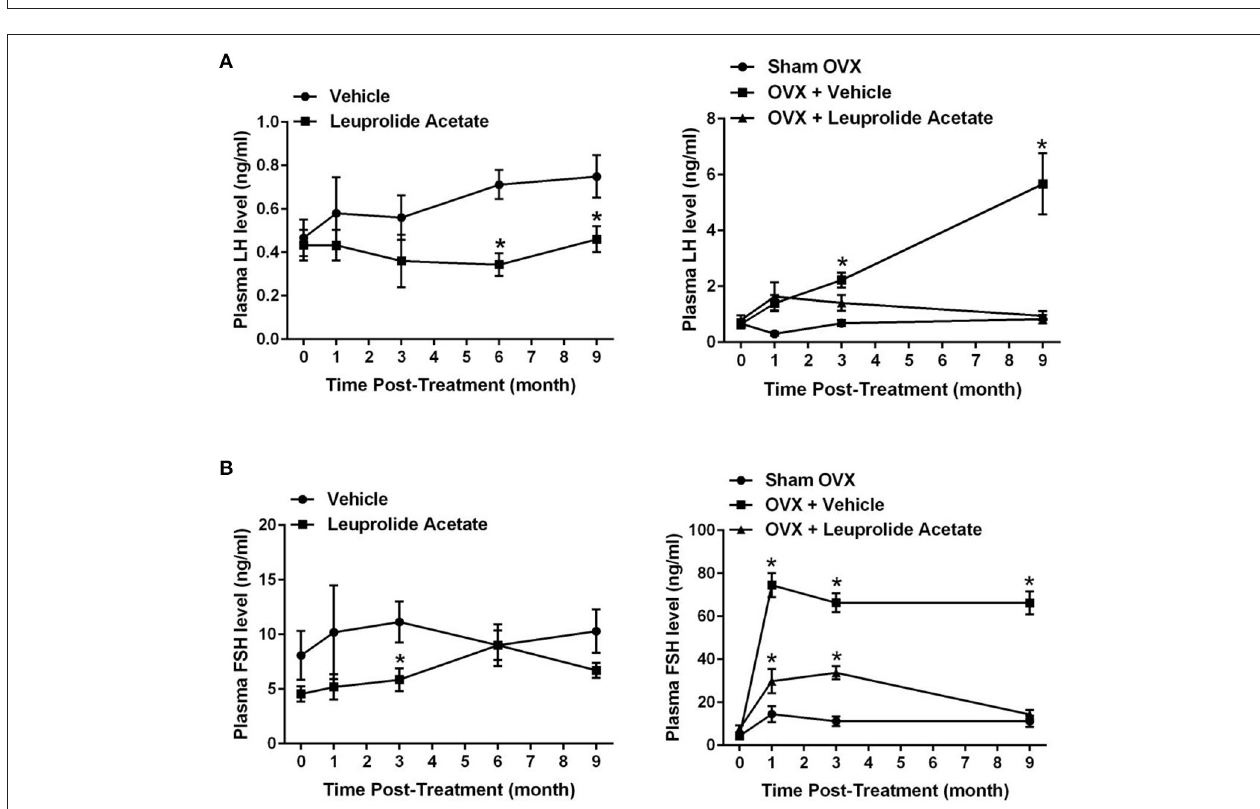
FIGURE 2 | Changes in plasma LH and FSH with aging in ovariectomized and leuprolide acetate treated mice. Female C57B6JL mice at the age of 7.5 months were treated either with vehicle (saline) or leuprolide acetate (1.5 mg/kg) monthly, blood was taken at 0, 1, 3, 6, and 9 month and LH (A) and FSH (B) concentrations were assayed via RIA. C57B6JL mice at the age of 7.0 months were sham operated or ovariectomized. Ovariectomized animals were either treated with vehicle (saline) or leuprolide acetate (1.5 mg/kg) monthly for 9 months and blood samples collected at 0, 1, 3, and 9 month, and LH (B) and FSH (D) levels assayed via RIA. Results are presented as mean ± SEM, n = 6, * p <